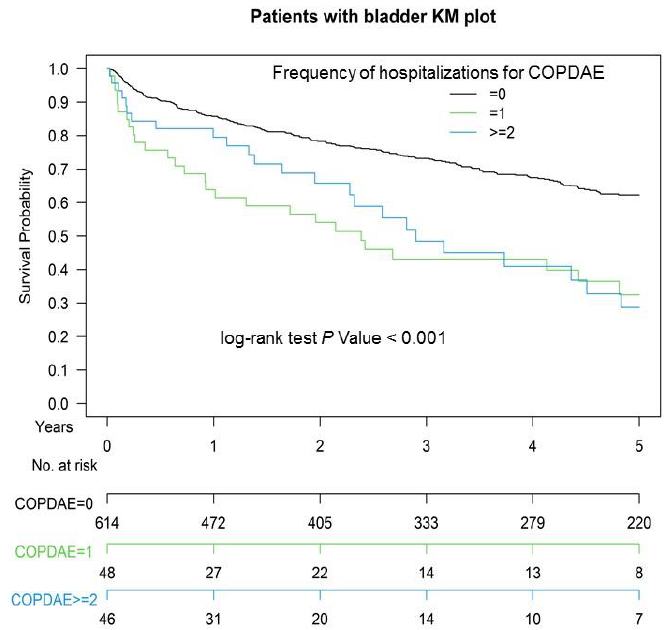
Figure 2. Kaplan–Meier (KM) survival curves of propensity score-matched patients with muscle-invasive urothelial carcinoma of the bladder with hospitalization frequency for COPDAE within 1 year before definitive CCRT for bladder preservation, COPDAE, chronic obstructive pulmonary disease with acute exacerbation; CCRT, concurrent chemoradiotherapy.